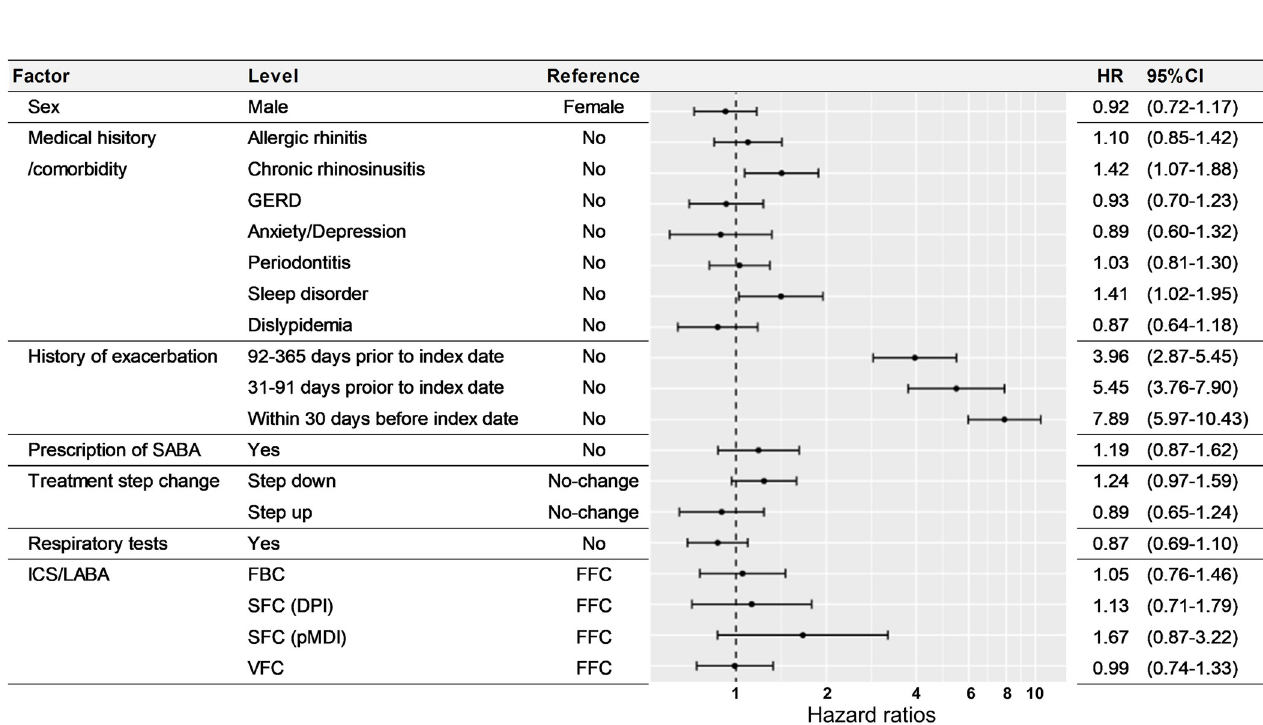
Fig 5. Factors associated with exacerbations. HR, hazard ratio; 95% CI, 95% confidence interval. HRs and 95% CIs were derived from multivariate Cox regression analysis adjusted for age, region, and month of switching, in addition to the variables listed above.